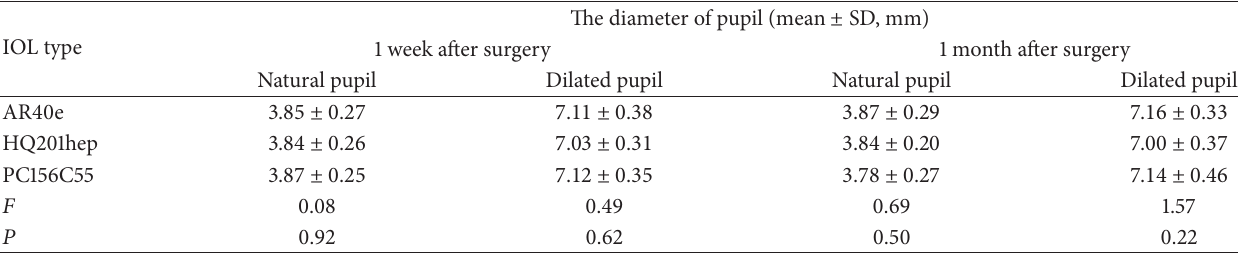
Table 2: The mean diameter of pupil 1 week after surgery and 1 month after surgery.